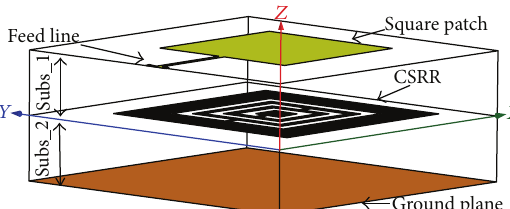
Figure 1: 3D side view of miniaturized antenna consisting of CSRR (metamaterial) layer between the square patch and ground plane.